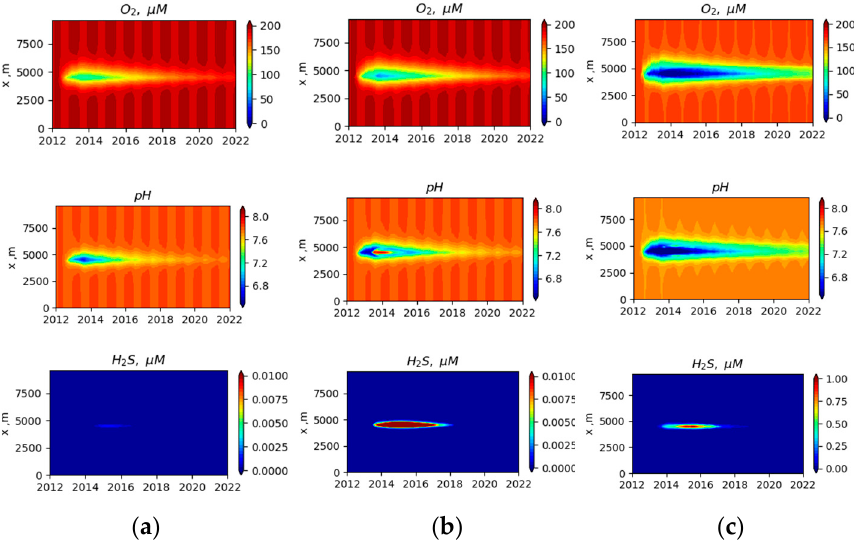
Figure 14. Modeled temporal variability of O2, pH and H2S in the bottom layer at a transect through the fish farm in case of an absence of relaxation of waste: single waste run ( a ), double waste rate ( b ), single waste run without bio-irrigation ( c ).